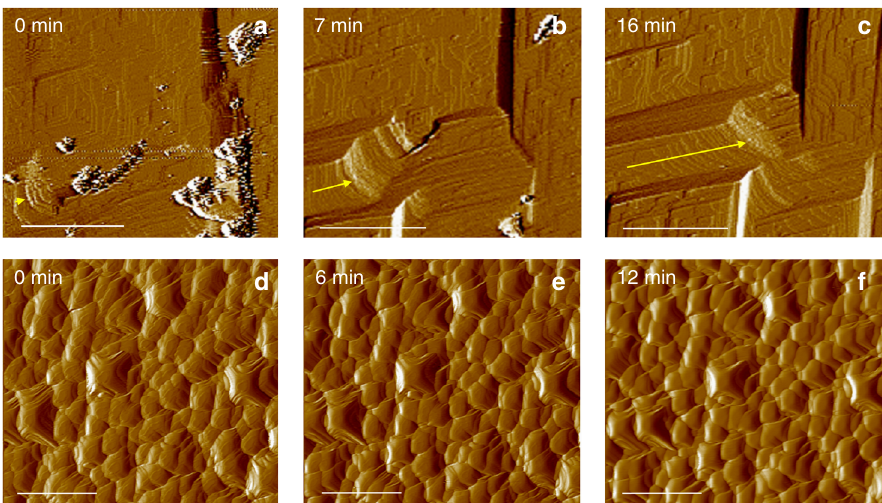
Fig. 7 Time-resolved in situ AFM images of the dissolution of calcite. a – c control (untreated) and d – f bacterially treated (104) calcite surface exposed to fl owing 1 M MgSO = 0 min represent the moment when the saline solution was injected into the AFM fl uid cell. The yellow arrows in a – c 4 solution. Time show the retreat of the macrostep over time (due to fast calcite dissolution). Note that no dissolution features are observed in d – f over the time course of the dissolution experiment. Scale bar : 1 µ m